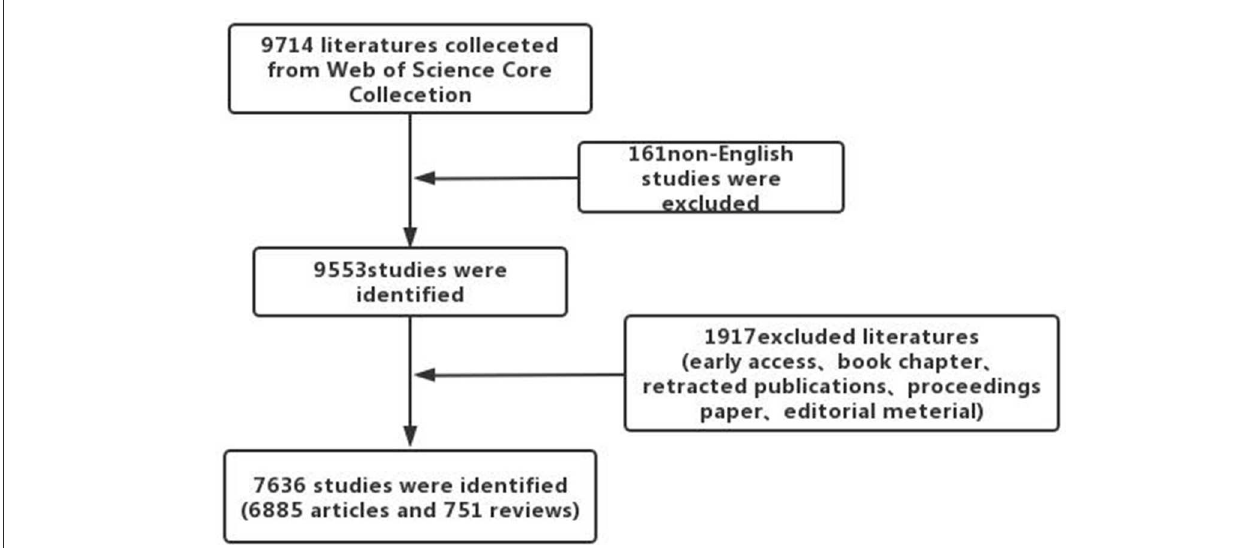
FIGURE1 Bibliometric analysis of prediabetes presented in the workflow.